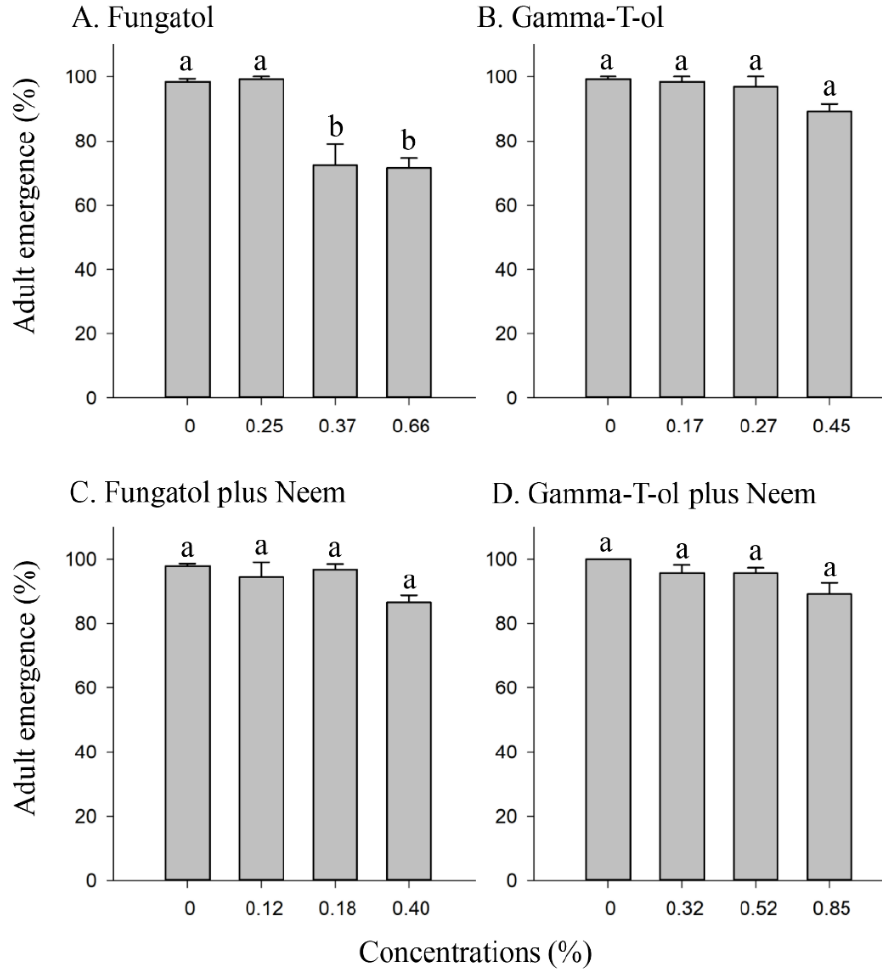
Figure 2. The effect of different concentrations of Fungatol ( A ), Gamma-T-ol ( B ), Fungatol plus neem ( C ), and Gamma-T-ol plus neem ( D ) on adult emergence of A. colemani from treated mummies in the glasshouse. The mean differences between the concentrations of Gamma-T-ol ( B ) and Gamma- T-ol plus neem ( D ) were compared using the Kruskal–Wallis ( p < 0.05) test followed by Dunn’s pairwise comparisons. One-way ANOVA with the Duncan multiple comparisons test revealed significant differences between the concentrations of Fungatol ( A ) and Fungatol plus neem ( C ). Different lowercase letters above bars represent significant differences at p < 0.05. Data presented are mean ± SEM.